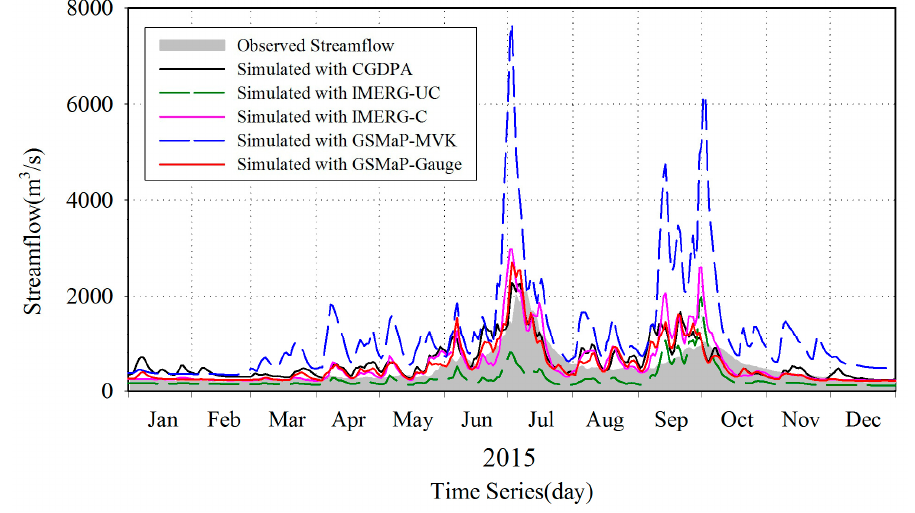
Figure 10. Daily observed and simulated streamflow with gauge benchmarked parameters over the upper Yellow River basin. Table 6. Comparison of daily and monthly observed and simulated streamflow when the Variable Infiltration Capacity (VIC) model was forced by the gauge ‐ and satellite ‐ based precipitation datasets in 2015.